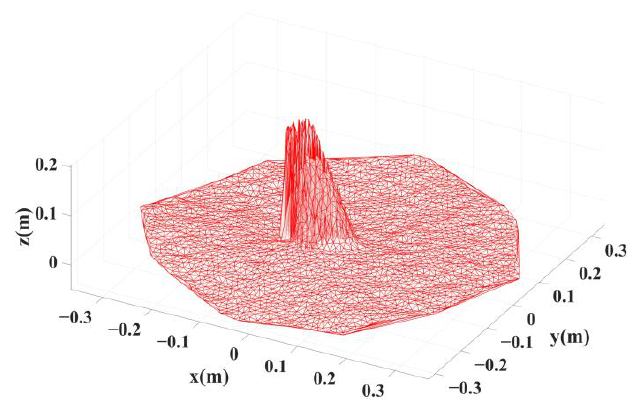
Figure 5. Triangular meshes in a 3D coordinate frame.